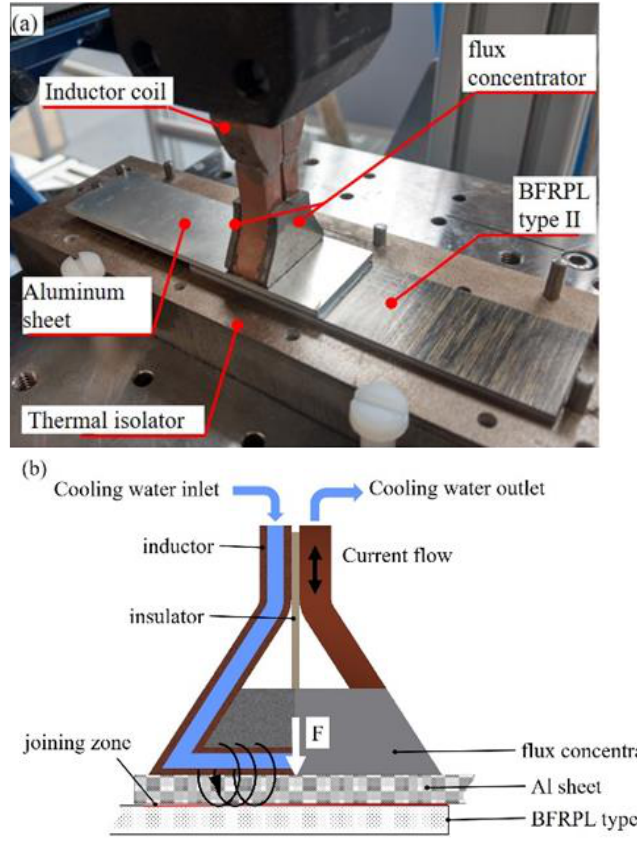
Figure 2. ( a ) The inductive contact joining (ICJ) experiment set-up and ( b ) schematic diagram representing the mechanism of ICJ [20].